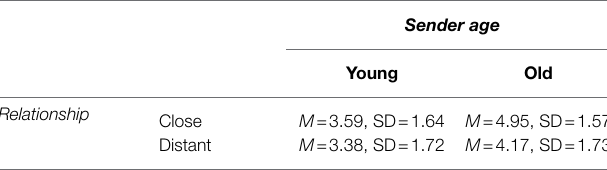
TABLE 3 | The mean score and standard deviation of friendliness by younger